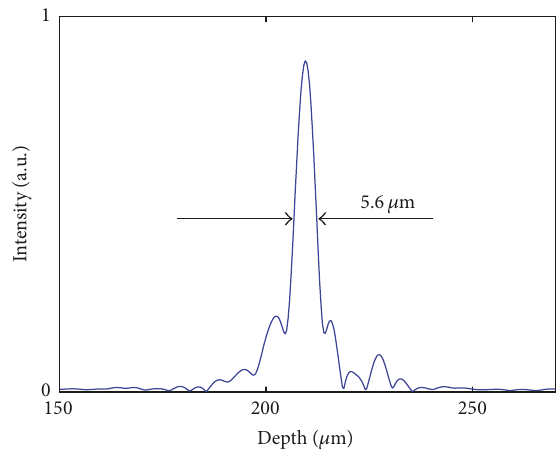
Figure 6: The measured axial resolution of the implemented SD- OCT